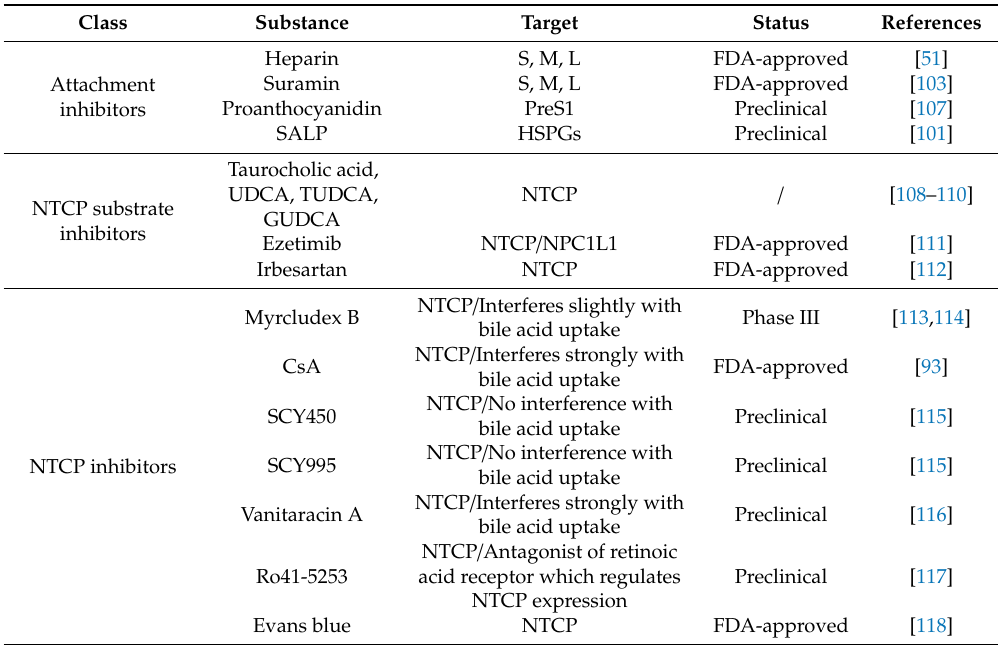
Table 2. HBV entry inhibitors. Based on table from Ref. [106] and subsequently